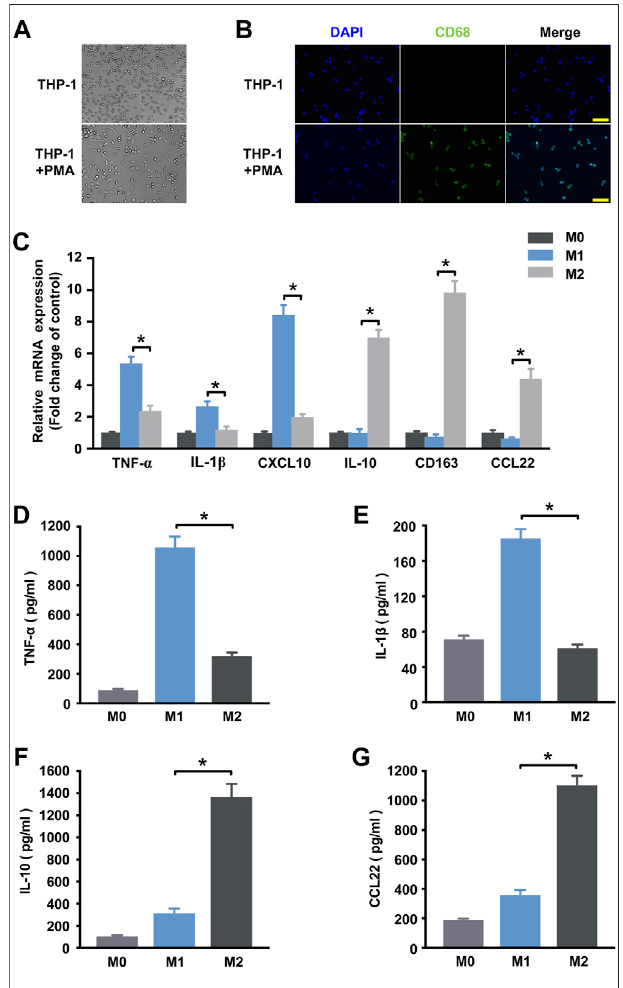
FIGURE 1 | Determination of polarized M1 and M2 macrophages. (A) Induction of the macrophage-like phenotype in THP-1 cells. THP-1 cells were differentiated by PMA treatment for 48 h. Morphological changes were analyzed by comparing (up) undifferentiated cells versus (down) differentiated cells. Arrows indicate typical “ spreading ” . (B) Expression of the macrophage marker CD68 (green) in THP-1 cells at steady state (no treatment) and following 48 h of PMA stimulation. Nuclei were stained with DAPI (blue). Scale bar = 100 µm. (C) THP-1 macrophages treated with IFN- γ and LPS for M1 polarization or IL-4 for M2 polarization. The expression of cytokines of THP-1 macrophages was detected by qRT-PCR at 18 h post- treatment.M1 markersTNF- α (D) and IL-1 β (E) andM2 markersIL-10 (F) and CCL22 (G) inthesupernatantweredetectedbyELISAat48 hpost-treatment. Data are expressed as the means ± SD of at least three independent experiments ( n = 4). p < 0.05, signi fi cant difference between M1 and M2